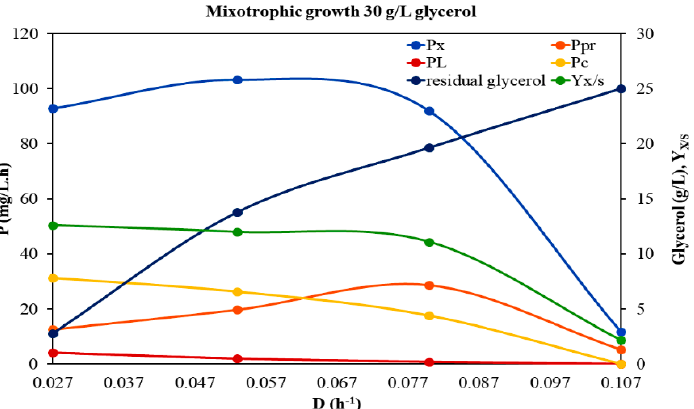
Figure 3. Effect of D on the growth of A. protothecoides under mixotrophic conditions in BBM modified medium with initial glycerol concentration of 30 g/L. The variation in biomass productivity P x (mg/L · h), lipids productivity P L (mg/L · h), proteins productivity P Pr (mg/L · h), carbohydrates productivity P c (mg/L · h) residual glycerol and Y x/S , with D are displayed. The Y x/S has been increased a hundredfold (100